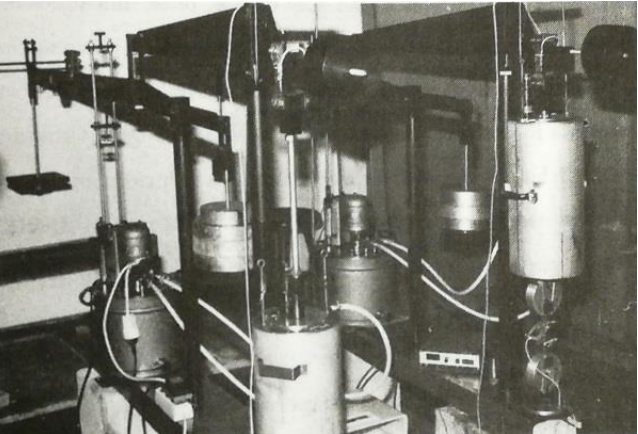
Figure 1. Experimental testing device.